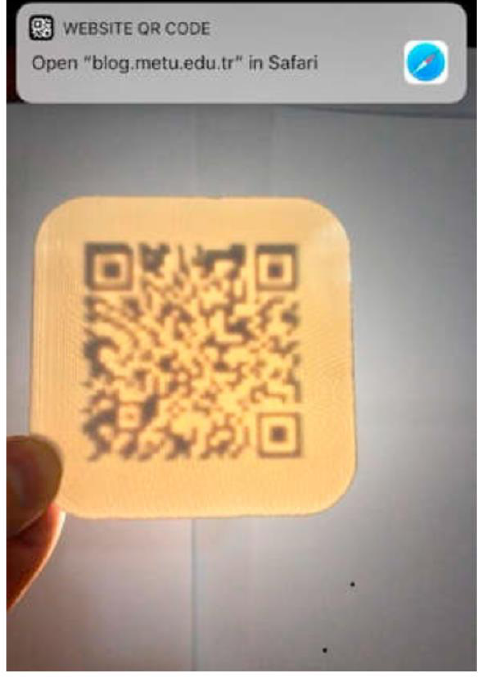
Figure 4. Example of scanning a QR code with background light. Reproduced from Reference [24], Gültekin et al. Procedia Manuf. 2019 , 39 , 519–525, https://doi:10.1016/j.promfg.2020.01.411, under the terms of the CC BY-NC-ND license.